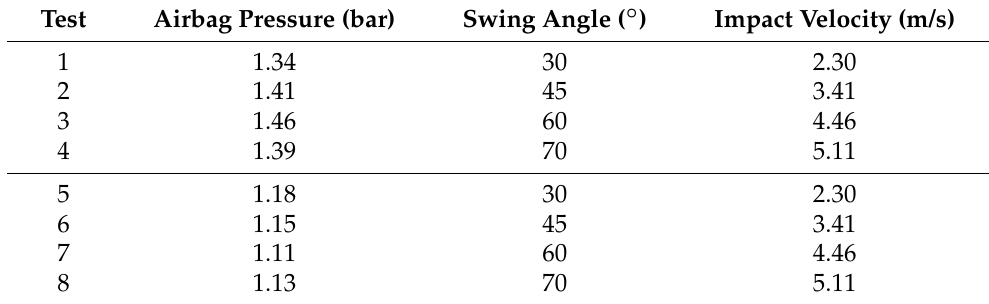
Table 2. Single-sensor test